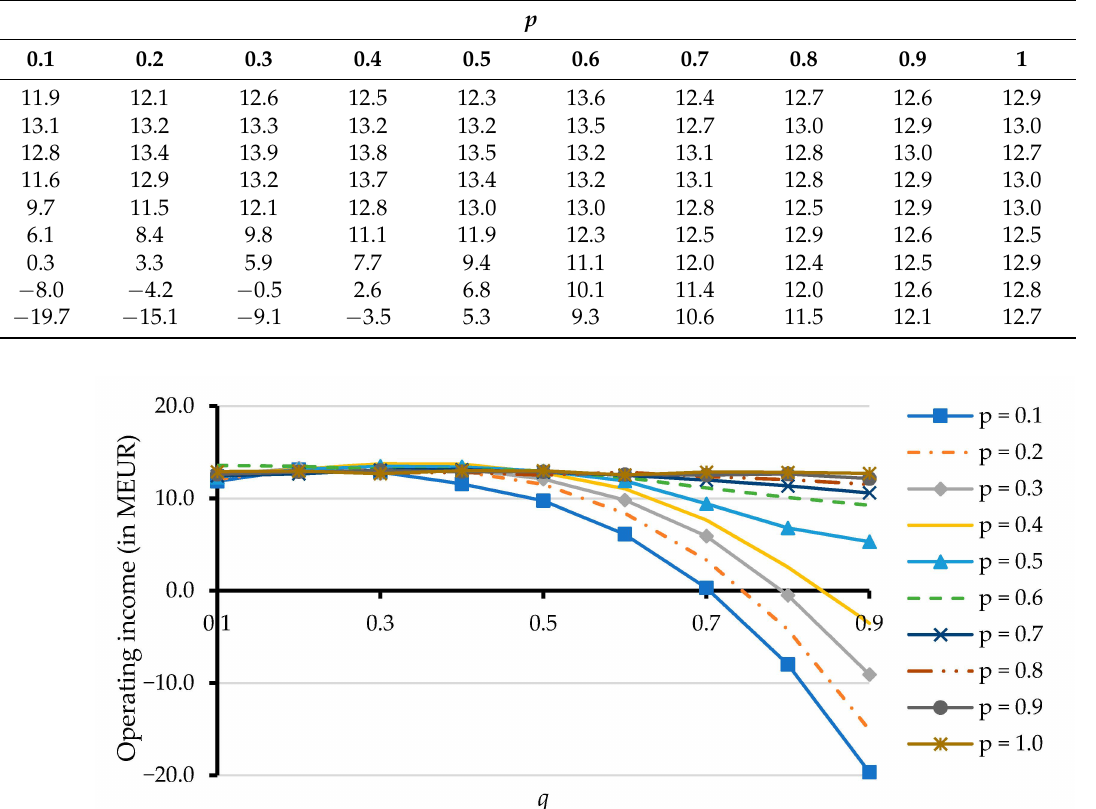
Figure 9. Operating income for different q and p (in MEUR). Graphic